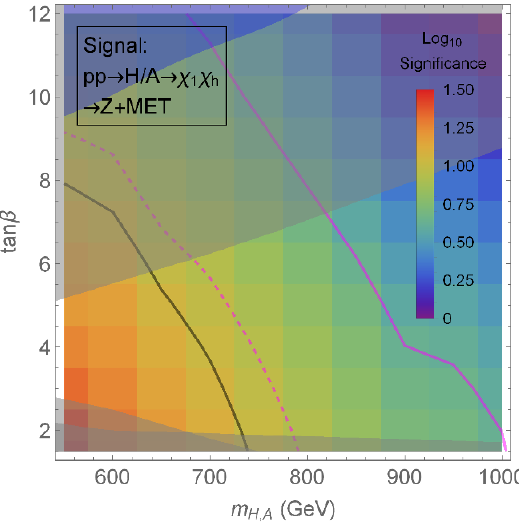
Figure 7 . The projected 2- (cid:27) exclusion limit (magenta) and 5- (cid:27) discovery reach (dashed ma- genta) for 13 TeV HL-LHC in the m A -tan (cid:12) plane, for (cid:12)xed m (cid:31) = 300 GeV and m (cid:31) = 100 GeV. 2 ; 3 1 The solid black curve denotes the corresponding 2 (cid:27) exclusion with 300 fb (cid:0) 1 . The colors on each benchmark point tile represent the projected signi(cid:12)cance of our analysis at 13 TeV HL-LHC. For comparison, we also show the projected limits at HL-LHC for heavy Higgs searches in the (cid:28)(cid:28) [84] and t (cid:22) t [4] (cid:12)nal states in the upper shaded and lower shaded regions, respectively. The current constraints from A=H ! (cid:28)(cid:28) searches [1, 2] are shown in the blue shaded region. The lower shaded region that vanishes around 700 GeV represents possible limits from the 4-top (cid:12)nal state, for t (cid:22) t associated production of the heavy Higgs ( pp ! t (cid:22) tH=A; H=A ! t (cid:22) t ) (taken from